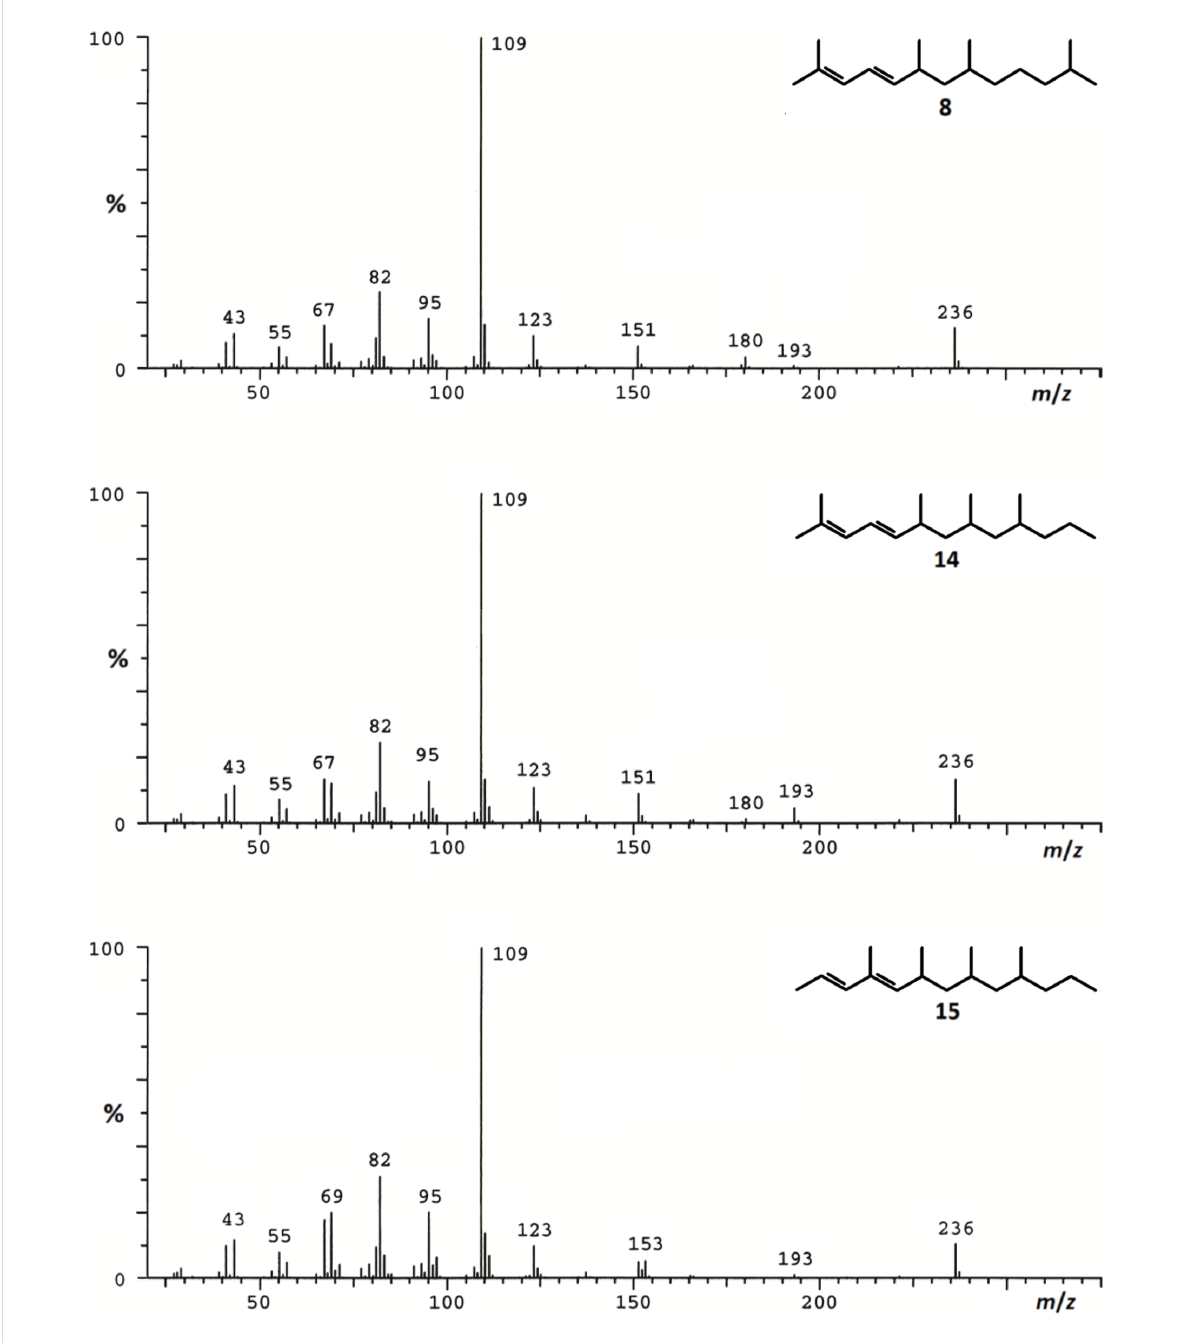
Figure 3: 70 eV EIMS of synthetic tetramethyltrideca-2,4-dienes 8 , 14 and 15 . These spectra were run under the same analytical conditions as described in the original paper [12].